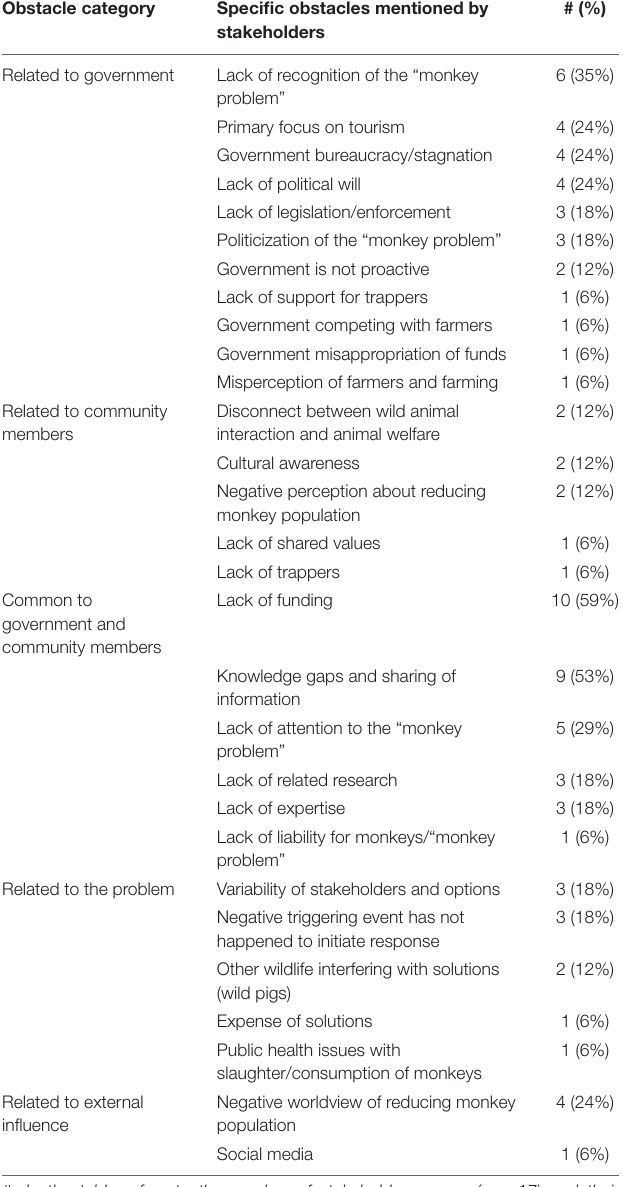
TABLE 4 | Categorization of stakeholder perceived options of the St. Kitts’ “monkey problem.” Option category